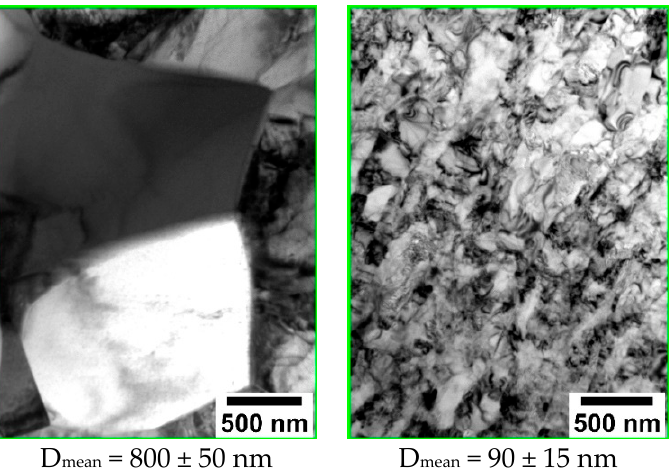
Figure 10. TEM images of the coarse grain (CG) and nanostructured (NS) Ti.